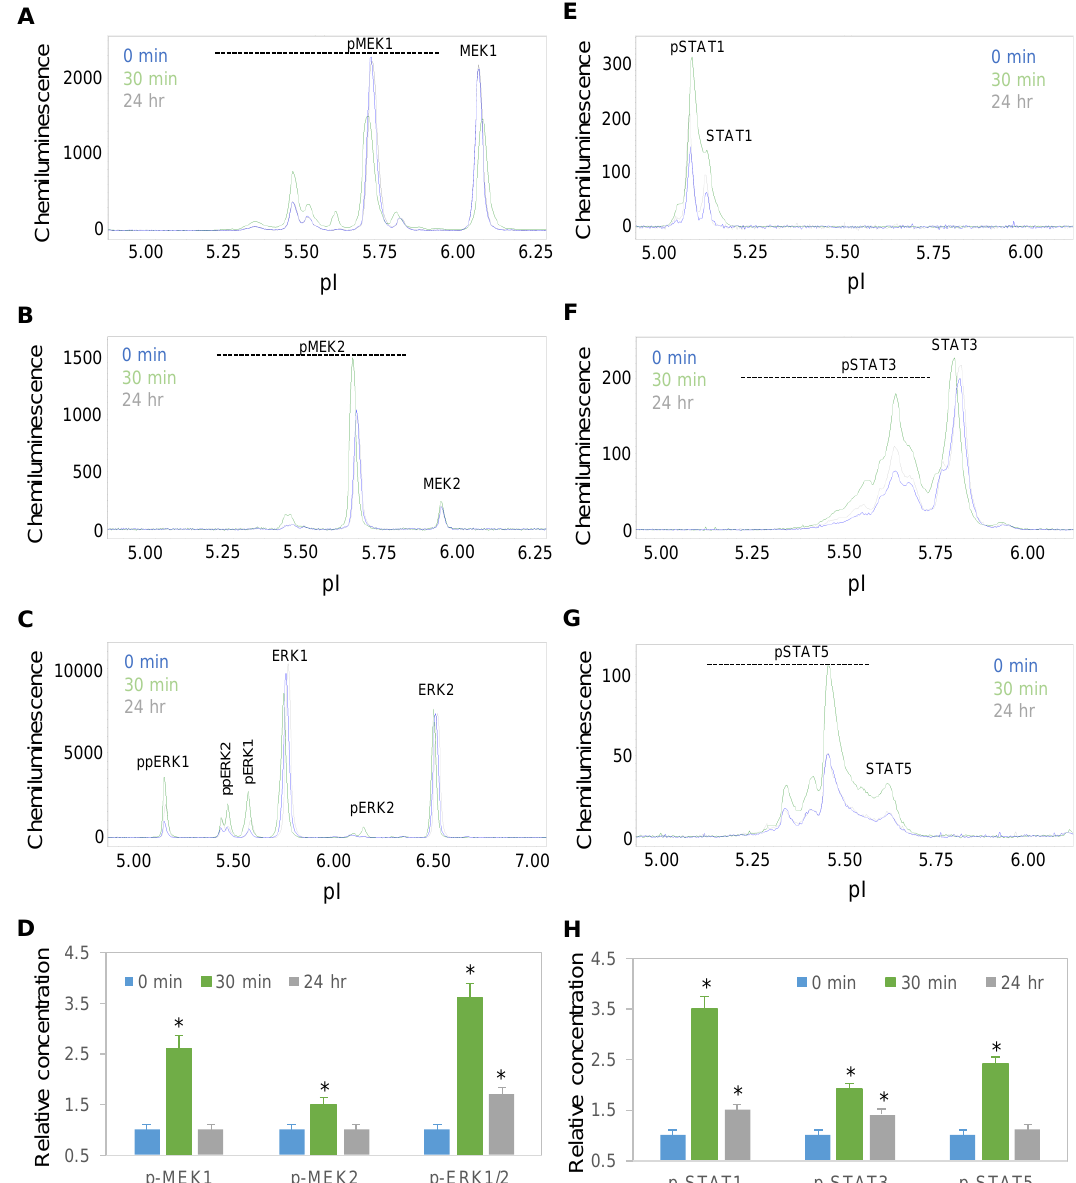
Figure 5. Time-dependent activation of the MAPK and JAK / STAT signaling pathways by copaiba essential oil. ( A – C ) MEK1 ( A ), MEK2 ( B ), and ERK1 / 2 ( C ) profiles as functions of time after treatment. ( D ) Relative concentrations of the MEK1, MEK, and ERK1 / 2 phosphoisoforms as a function of time after treatment. ( E – H ) STAT1 ( E ), STAT3 ( F ), and STAT5 ( G ) profiles as functions of time after treatment. ( H ) Relative concentrations of the STAT1, STAT3, and STAT5 phosphoisoforms as functions of time after treatment. The relative concentration describes the fold change in a protein phosphoisoform after treatment compared to the control condition. The error bars are the standard deviations of six repeated measurements per experimental condition. The asterisks indicate statistical significance for p ≤ 0.05 versus the control. SH-SY5Y cells were treated with 100 ng / mL copaiba essential oil.